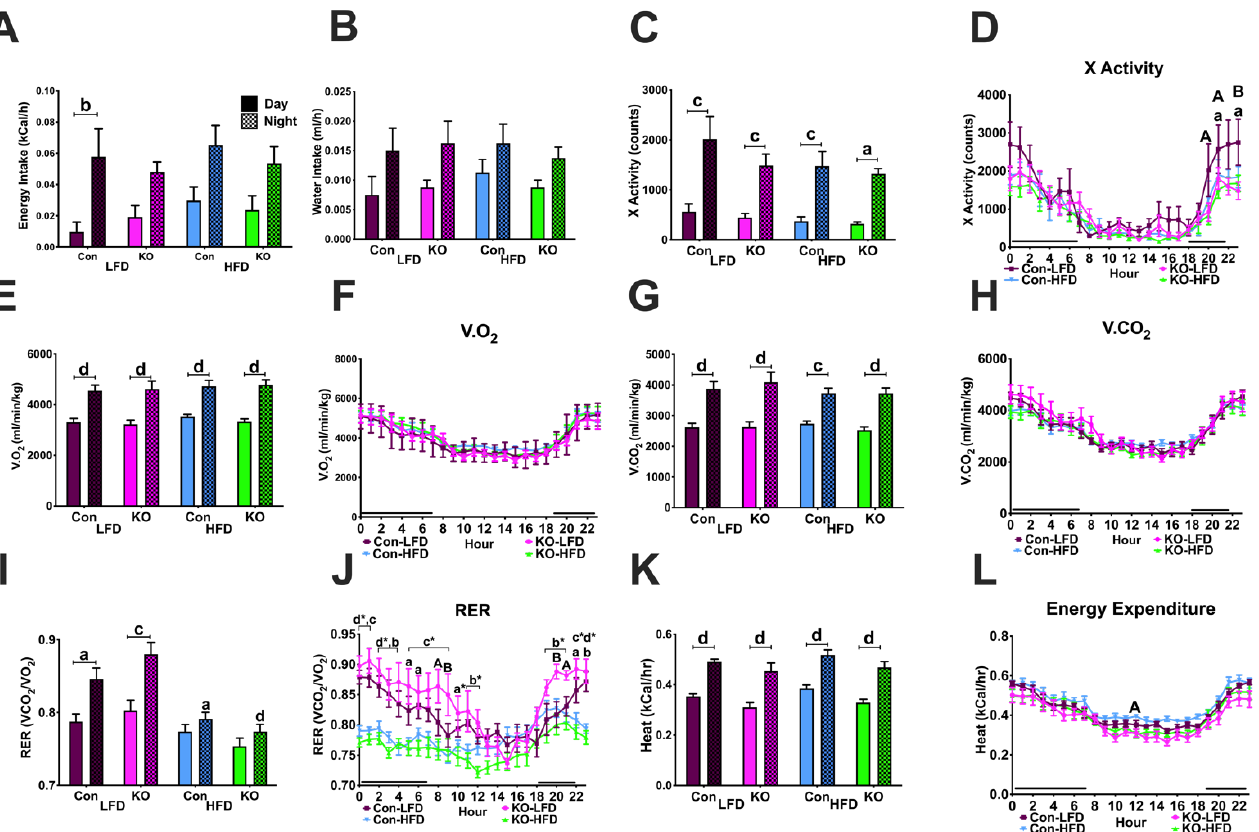
Figure 5. Metabolic response to HFD in intact control and Kiss1-GHSR KO (KO) female mice fed LFD or HFD for 8 weeks. ( A ) Daytime and nighttime energy (kCal) and ( B ) water intake, ( C ) total X-activity (counts) and ( D ) Hourly X-activity. ( E ) Daytime vs. nighttime volume of oxygen consumption (V.O2, ml/min/kg), and ( F ) Hourly volume of oxygen consumption (V.O2, ml/min/kg). ( G ) Daytime vs. nighttime volume of carbon dioxide production (V.CO2, ml/min/kg), and ( H ) Hourly volume of carbon dioxide production (V.CO2, ml/min/kg). ( I ) Daytime vs. nighttime respiratory exchange ratio (RER, V.CO2/V.O2), and ( J ) Hourly respiratory exchange ratio (RER, V.CO2/V.O2). ( K ) Daytime vs. nighttime energy expenditure (Heat, kCal/hr), and ( L ) Hourly energy expenditure (Heat, kCal/hr). For ( D , F , J , H , L ): Lowercase letters denote significance between diet in controls, lowercase letters with * denote significance between diet in Kiss1-GHSR-KOs, uppercase letters denote significance between genotypes on LFD. Lowercase letters above capped lines denote significance between time periods within treatment and genotype. A/a = p < 0.05; B/b = p < 0.01; C/c = p < 0.001; D/d = p < 0.0001. Data are represented as mean ± SEM and n = 8 mice per group. Data